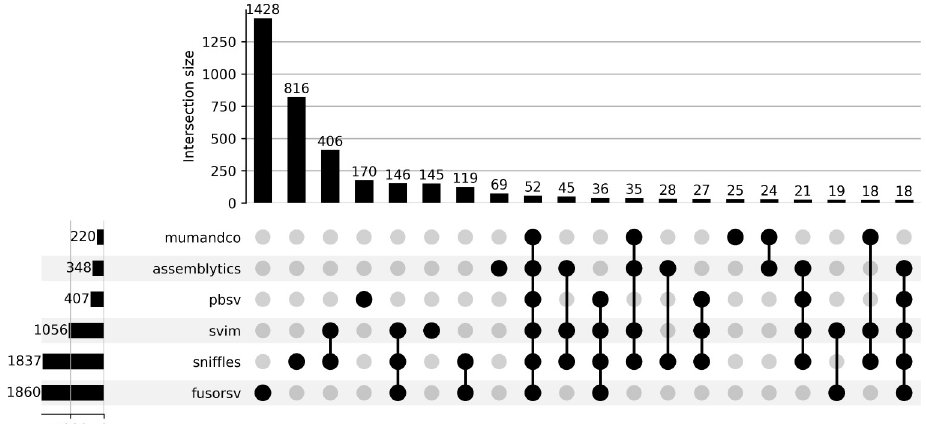
Fig 5. Caller agreement for tandem duplications spanning protein-coding genes predicted from long-read tools and FusorSV. Each row represents the set of genes covered by duplications for a given caller. The columns depict the intersection of these predictions between callers. The plot is limited to the 20 largest